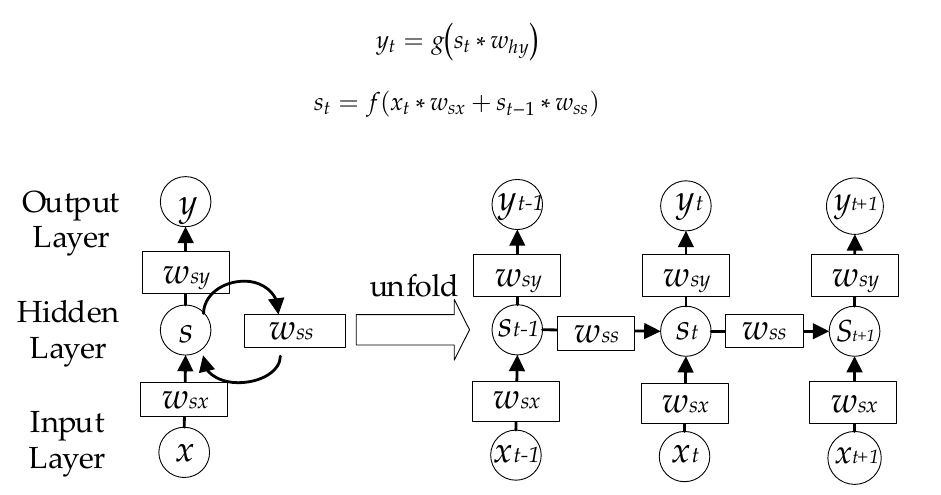
output layer y . When dealing with time-series data, the RNN can be unfolded as the right part. The output and hidden layers can be calculated according to Equation (5) and Equation (6), respectively.